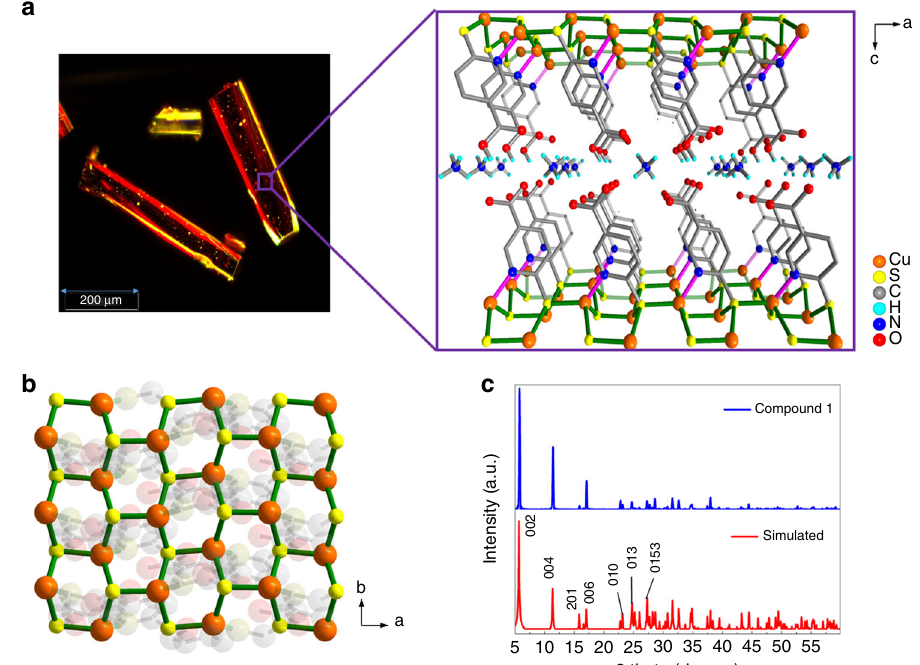
Fig. 2 Characterization and structural properties of 1 . a Dark- fi eld optical image and enlarged schematic view along the c -axis (Cu = orange, O = red, C = light gray, N = blue, S = yellow, H = cyan). b The corresponding 2D layer showing the Cu – S arrangement. c As-synthesized and simulated PXRD